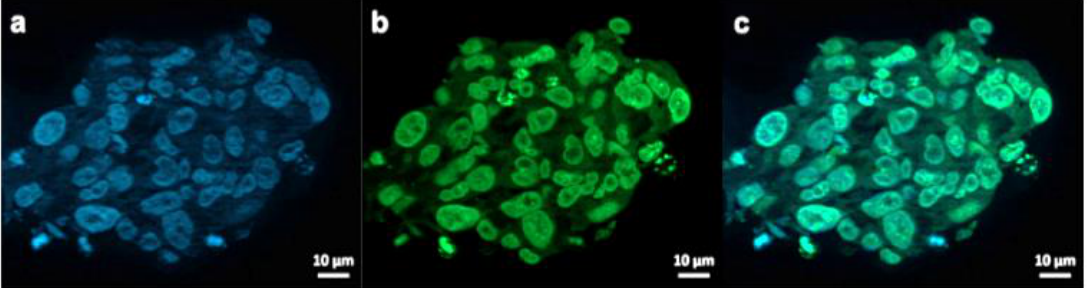
Figure 7. Exemplary fluorescence microscopy images of JHH520 cells after incubation with AuPVA-FITC NPs. Image ( a ) shows DAPI signals of cell DNA, image ( b ) FITC signals corresponding to AuPVA-FITC NPs and ( c ) a combined DAPI and FITC